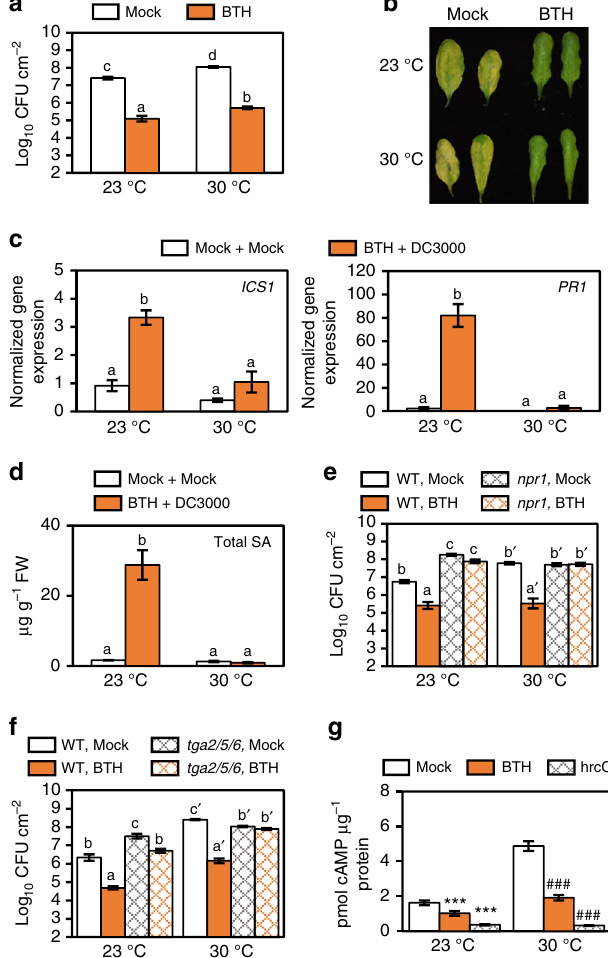
Fig. 7 BTH protection against Pst DC3000 at 30 °C requires NPR1 and TGAs but occurs without ICS1 and PR1 expression. a Bacterial growth in mock- or BTH-pre-treated plants ( n = 4) 3 days after vacuum-in fi ltration with Pst DC3000. b Disease symptoms three dpi in plants in a . c SA marker gene expression ( n = 3) and d SA metabolite quanti fi cation ( n = 4) 24 hpi of plants in a . Gene expression and LCMS data were processed and analysed as described in Fig. 2. Bacterial growth in mock- or BTH-pre- treated WT, e npr1 and f tga2/5/6 mutant plants ( n = 4) 3 days after vacuum-in fi ltration with Pst DC3000. g Translocation of bacterial effector proteins in plants ( n = 4) pre-treated with mock or BTH 24 h before syringe-in fi ltration with Pst DC3000(P nptII ::avrPto-CyaA ). Additional mock-treated plants ( n = 4 for each temperature) were in fi ltrated with hrcC − (P nptII ::avrPto-CyaA strains) as a negative control. Tissue was collected at 4 hpi for quanti fi cation of cAMP, which was normalized by total protein. All data are representative of three independent experiments; graphical data are presented as the mean ± s.e.m. with n = biological replicates. Letters indicate statistical signi fi cance based on a two-factor ANOVA with Tukey ’ s HSD post hoc analysis ( p < 0.05); samples sharing letters are not signi fi cantly different. Data in e and f were analysed in two groups based on temperature as indicated by the prime symbol ( ′ ). Symbols in g denote statistical signi fi cance based on a one-factor ANOVA with Dunnett ’ s post hoc analysis (***, ### p < 0.001) using the mock-treated sample at each temperature as the means for